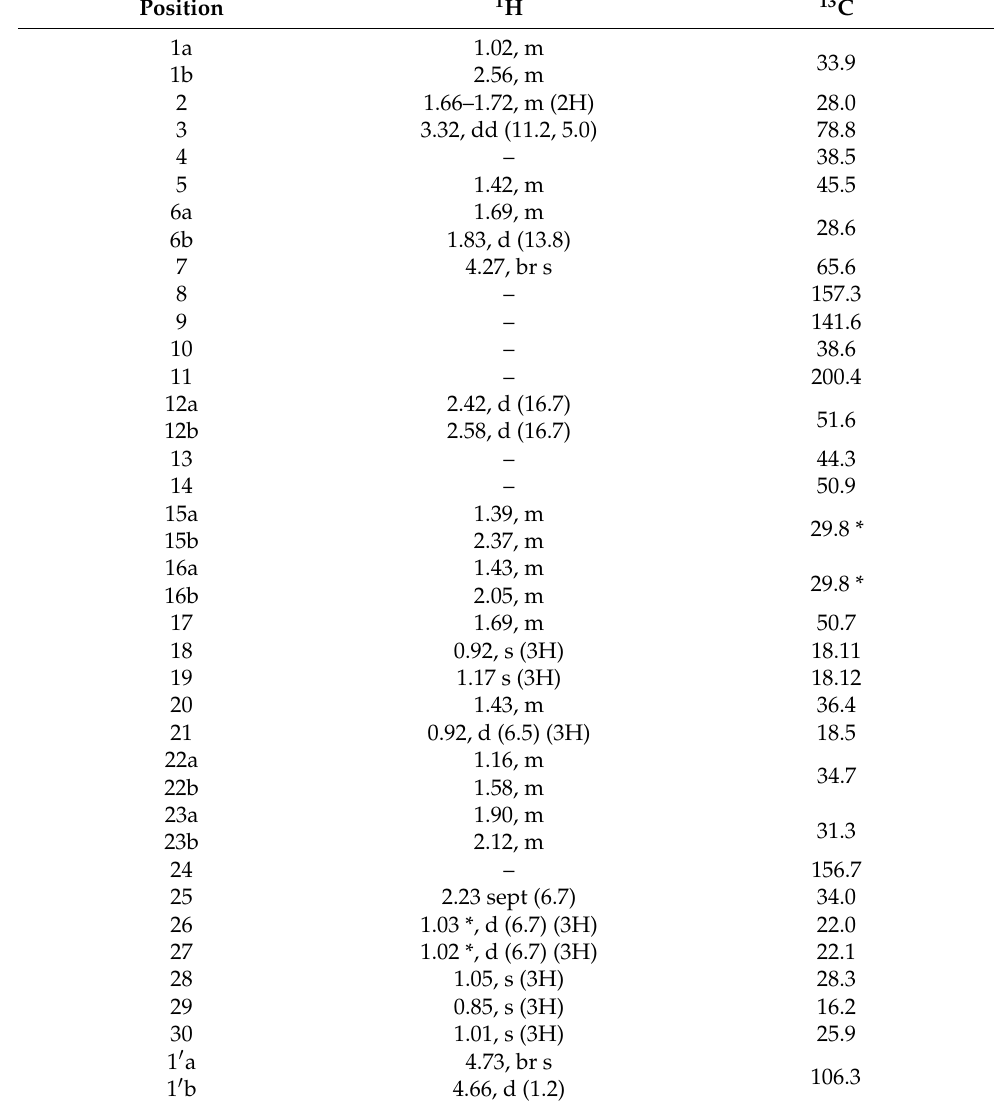
Table 1. 1 H (500 MHz) and 13 C NMR (125 MHz) data of compound 1 in CDCl 3 ( δ H in ppm, J in